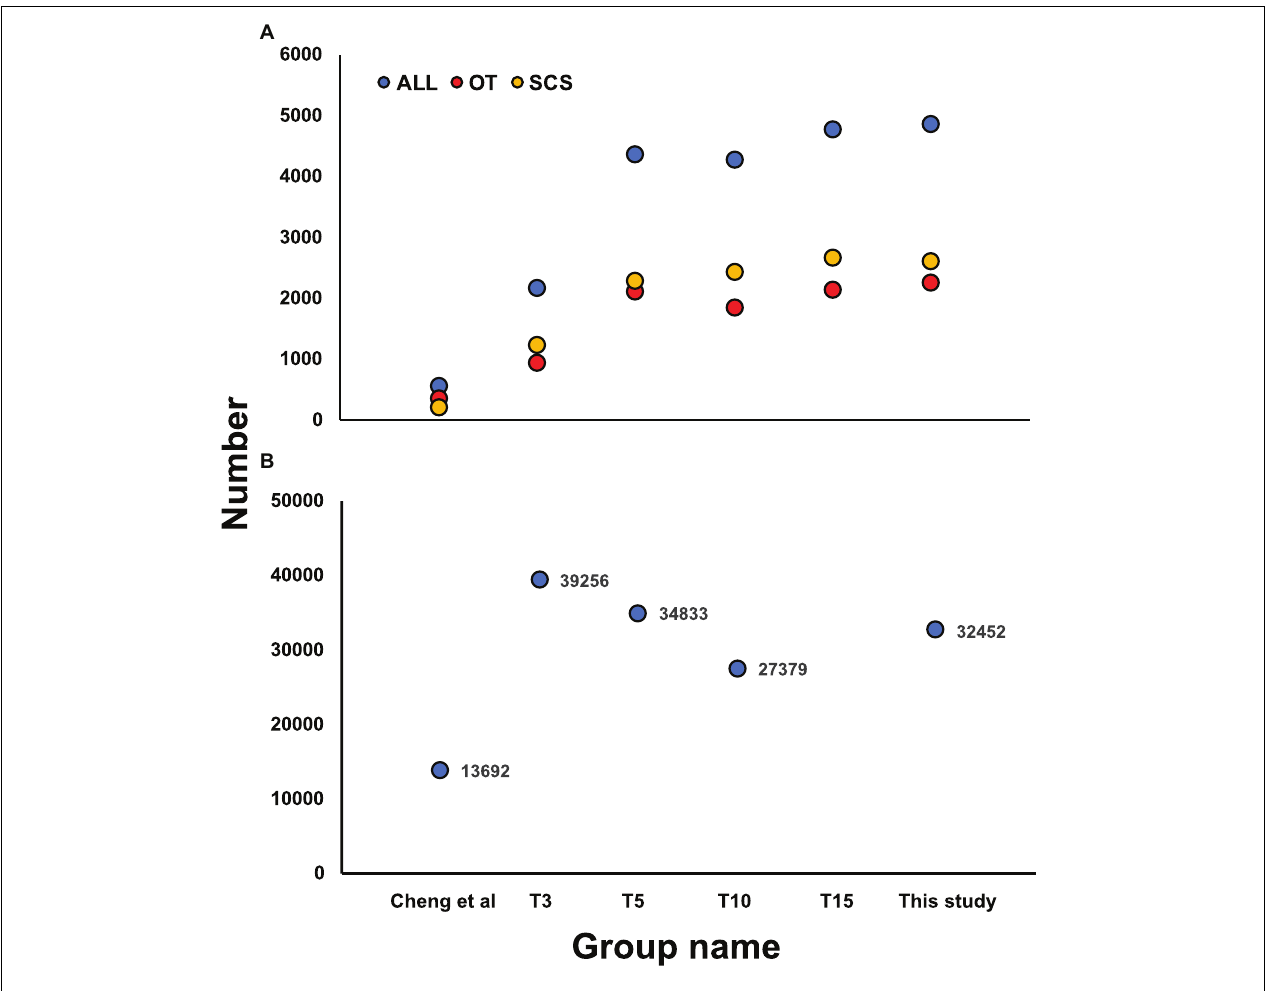
FIGURE 6 | (A) Number of DEGs identified based on the subsampling approach by random selecting 3 (T3), 5 (T5), 10 (T10), and 15 (T15) individuals from each local population and comparing with Cheng et al. (2019), with yellow, red, and blue dots indicating DEGs in SCS, OT, and total DEGs number, respectively. (B) Number of SNPs identified based on the subsampling approach by random selecting 3 (T3), 5 (T5), and 10 (T10) individuals from each local population and comparison with Cheng et al.